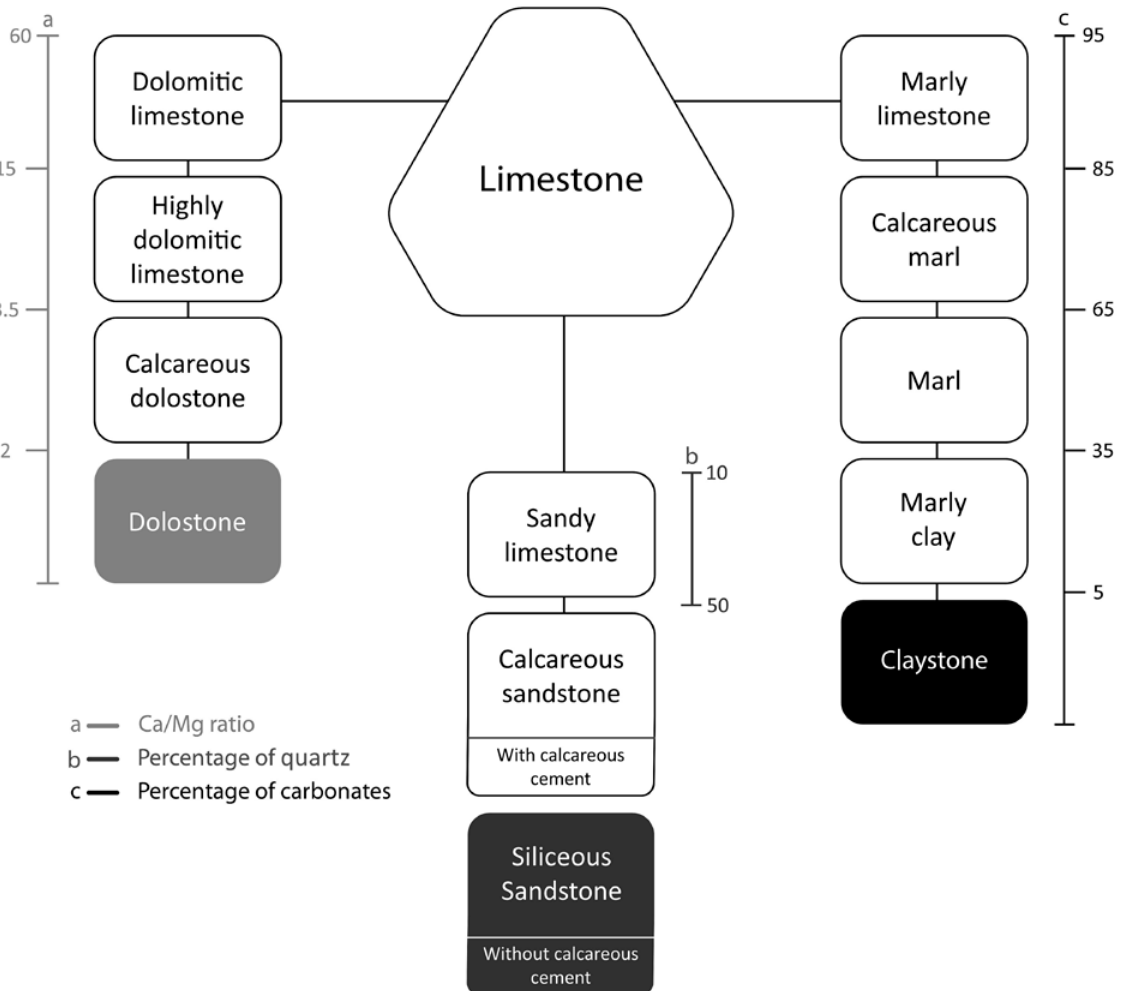
Figure 1. Classification of sedimentary rocks including limestones as an end member of the sedimentary